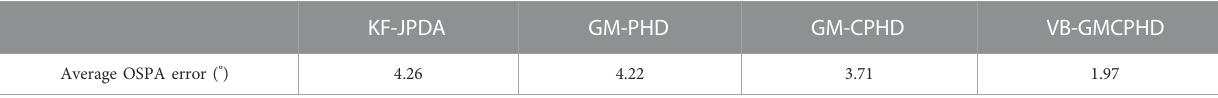
TABLE 2 The average OSPA errors of the tracking results of KF-JPDA, GM-PHD fi lter, GM-CPHD fi lter, and VB-GMCPHD fi lter in one tracking step when processing the experimental data with added